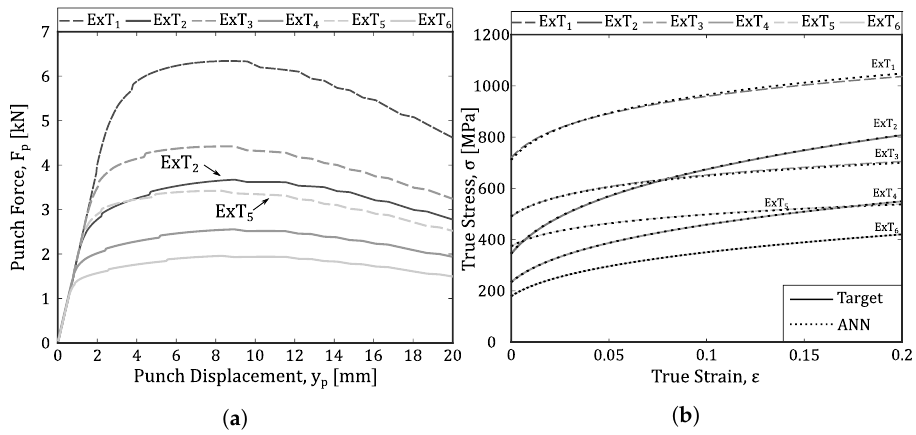
Figure 19. Three point bending test ( a ) punch force-displacement curves ( F p - y p ) obtained by finite element analysis for extra cases ExT 1 to ExT 6 , and ( b ) the corresponding true stress–strain curves ( σ - ε ). Table 7. Relative Error [%] between the target reference and the ANN output values for six different extra cases (ExT 1 to ExT 6 ) and considering two Swift parameters ( K and n ).